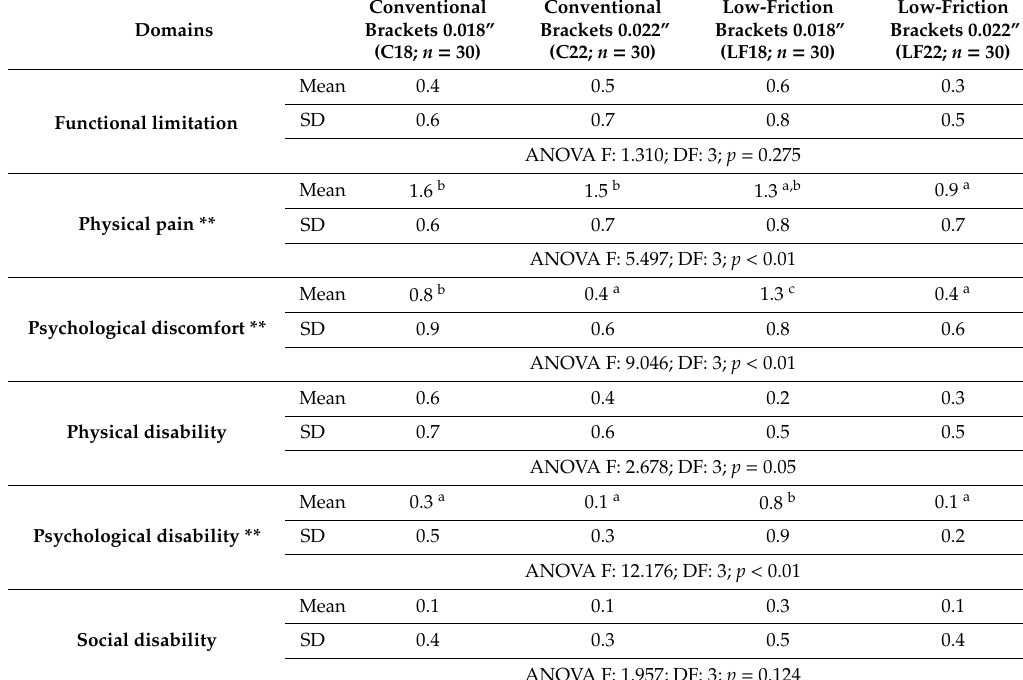
Table 3. Comparison of the groups in relation to the domains of the quality of life. ( n =